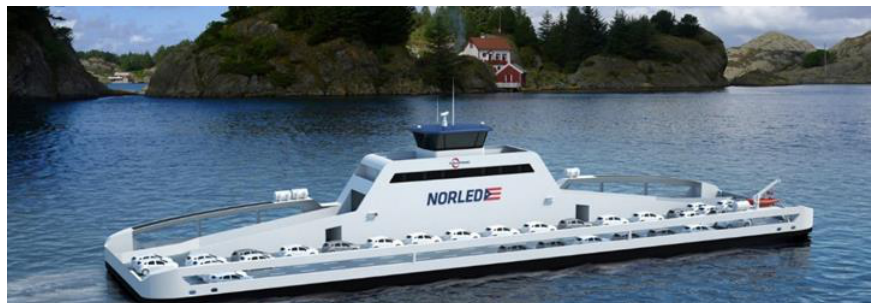
Figure 4. MF AMPERE — t he world’s first all -electric car ferry [50]. Figure 4. MF AMPERE—the world’s first all-electric car ferry [50].